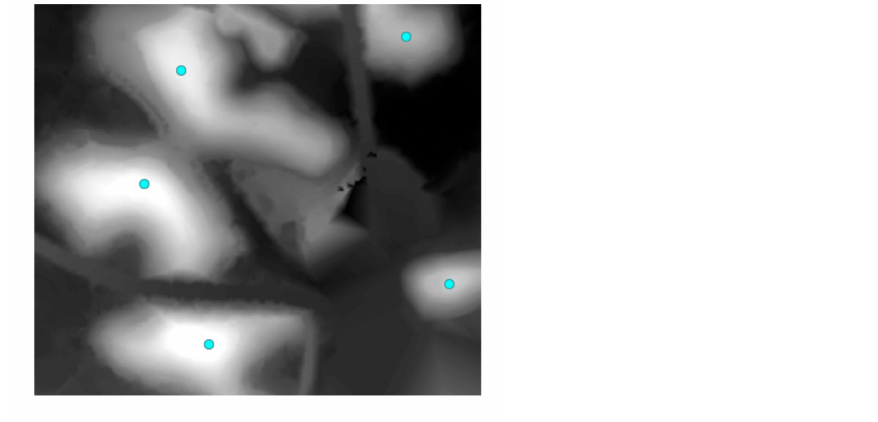
Figure 9. The distribution map of the experimental first dataset extracted using the reference method.